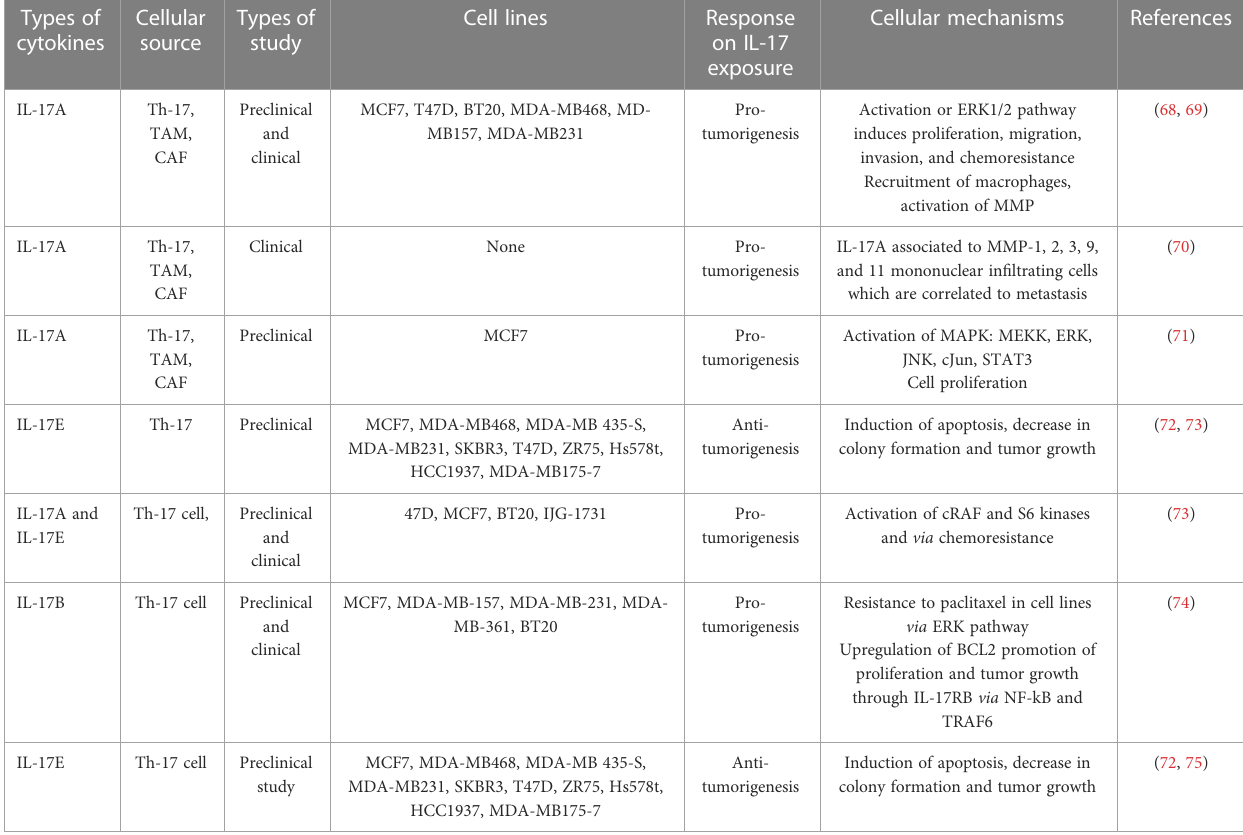
TABLE 1 In vivo and in vitro roles of IL-17 cytokines in breast cancer. Types